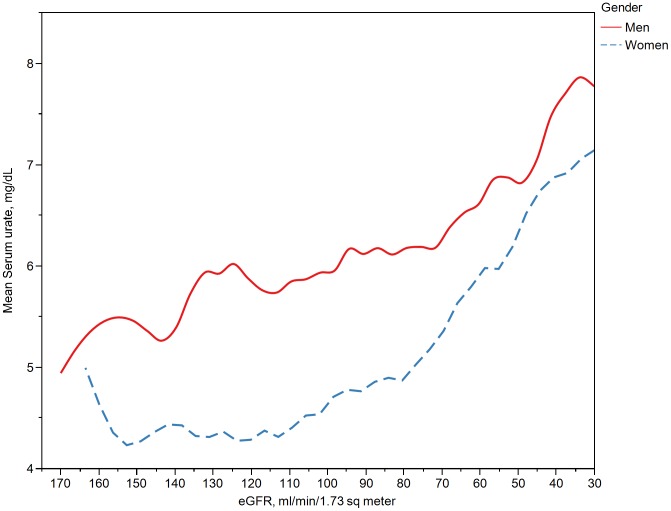
Bivariate association between estimated glomerular filtration rate and serum urate concentrations.The curves based on mean serum urate concentration vs. eGFR were fitted by locally weighted scatterplot smoothing (lowess) regressions using unweighted data. Conversion factors for units: serum urate in mg/dL to µmole/L, × 59.48.